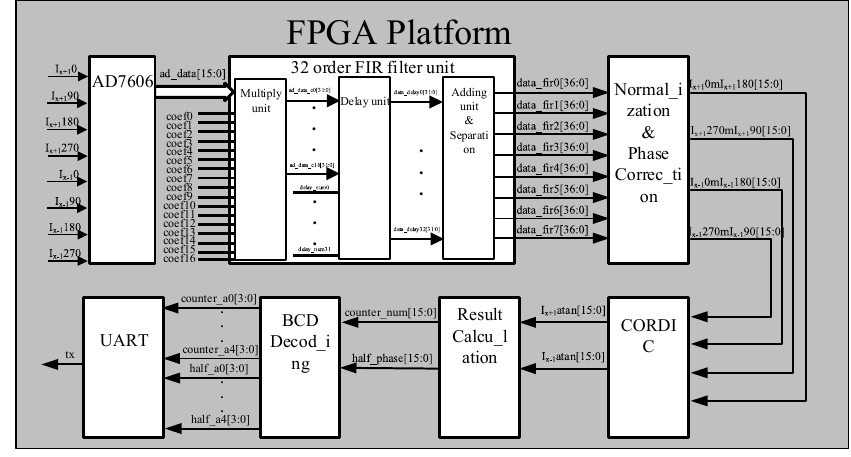
Figure 3. Field programmable gate array (FPGA) platform design.